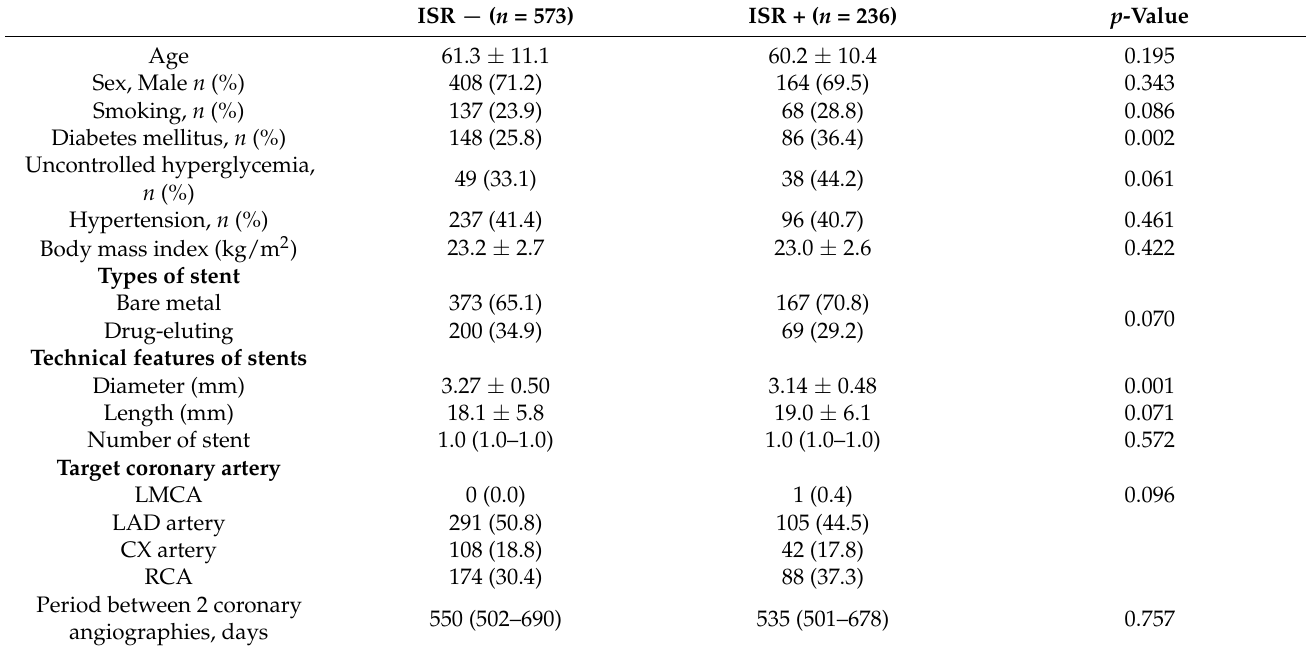
Table 1. Demographic, clinical and angiographic characteristics of the patients with and without